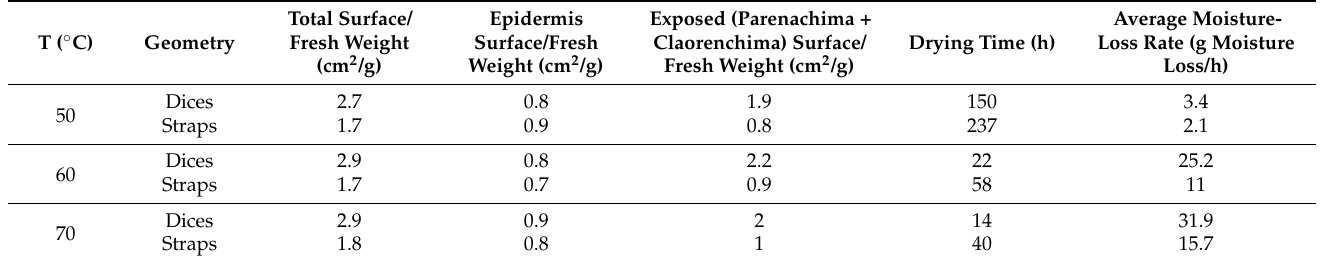
Table 5. Drying surface areas, drying times, and moisture-loss rates of prickly-pear cladodes.